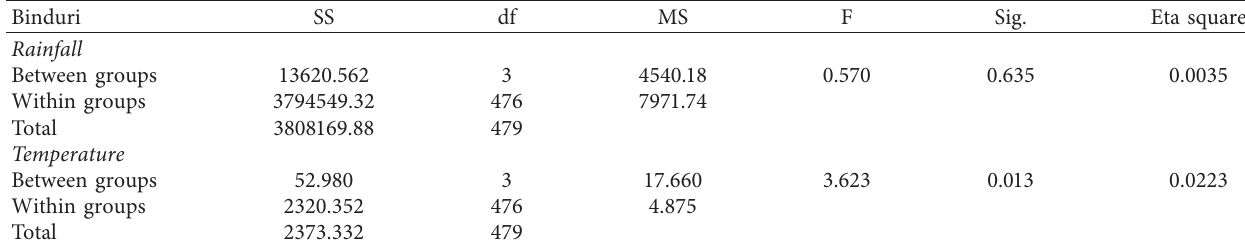
Table 7: ANOVA test statistics,